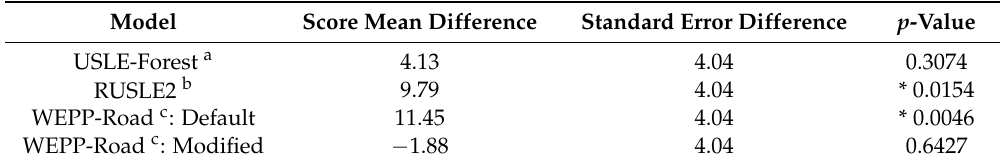
Table 3. Nonparametric analysis comparing each model to the measured data using Wilcoxon method. α =